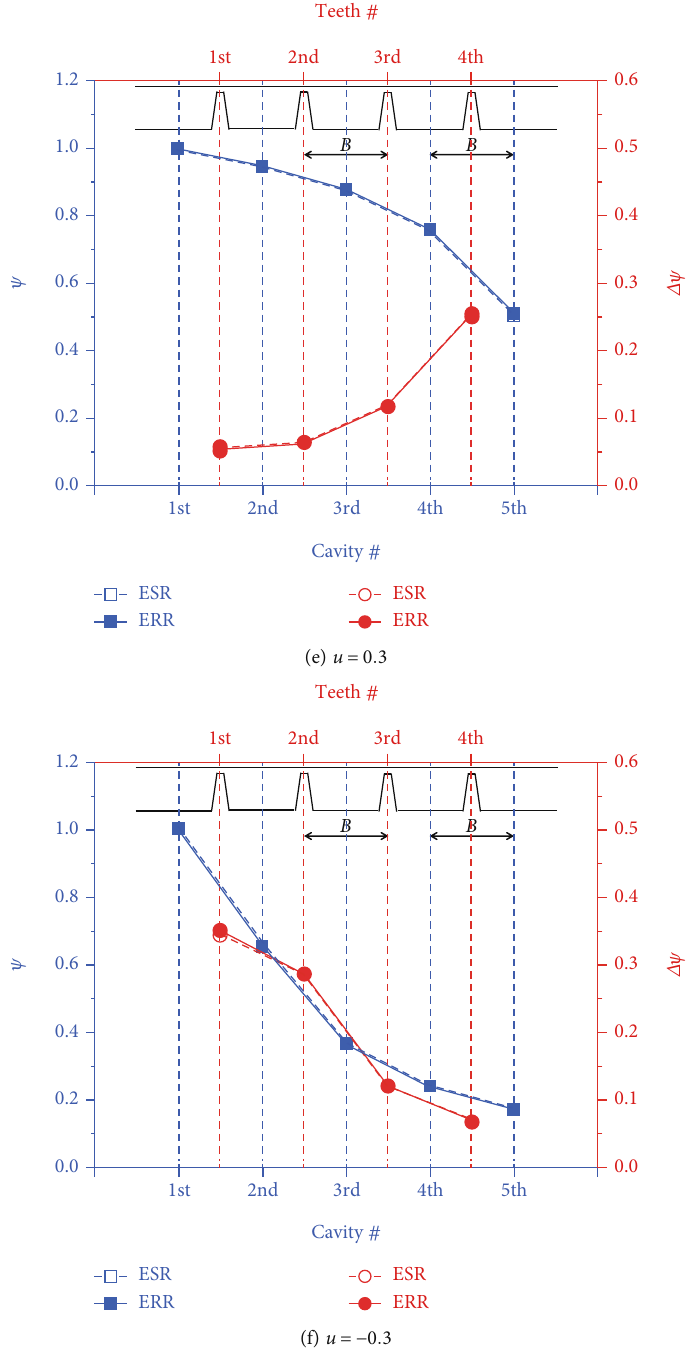
= 0 : 23 , and C = 0 : 067 U